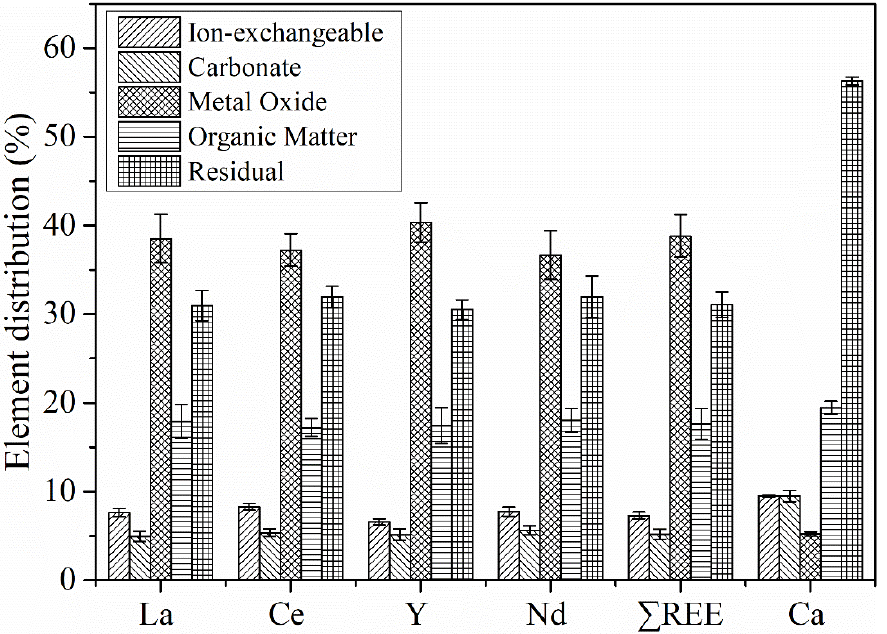
Figure 5. The modes of occurrence of REEs and calcium obtained by the SCE method in the PG.